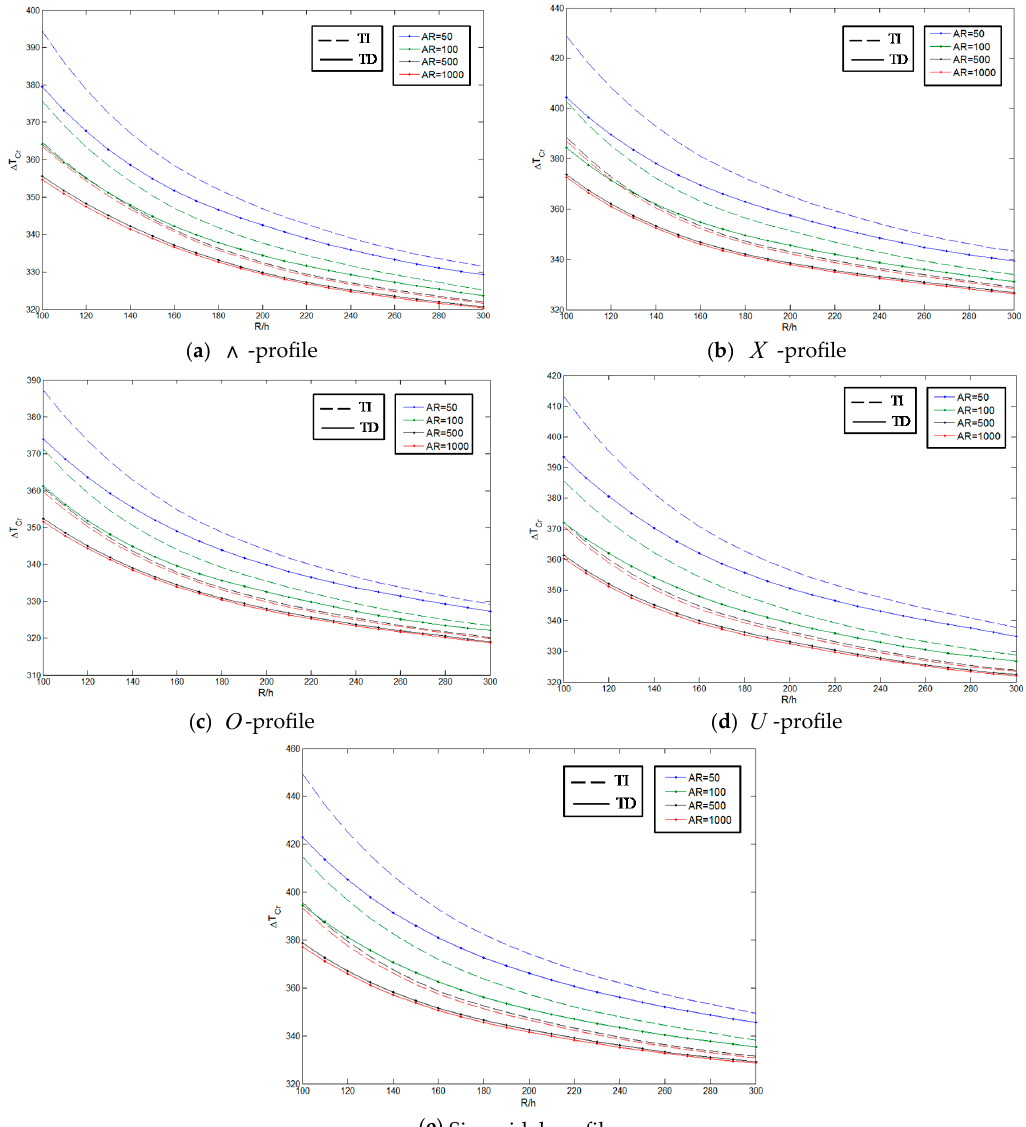
T  vs. / R h for different aspect ratios Figure 5. cr Figure 5. ∆ T cr vs. R / h for different aspect ratios A R considering L / R = 2, V ∗ N r = N s =